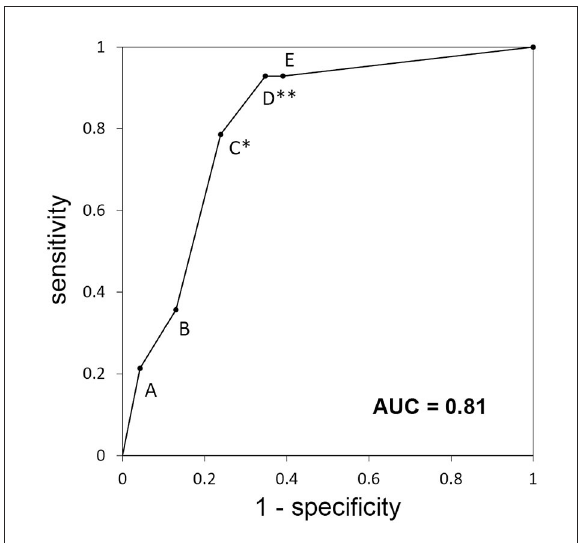
FIGURE2 Receiver-operating characteristic curve for the categories of the diagnostic algorithm used for the retrospective cohort. Each alphabet means the sensitivity and specificity when the patients classified A to X are diagnosed with “autoimmune epilepsy.” *Best optimal cutoff; **second optimal cutoff; AUC, area under the